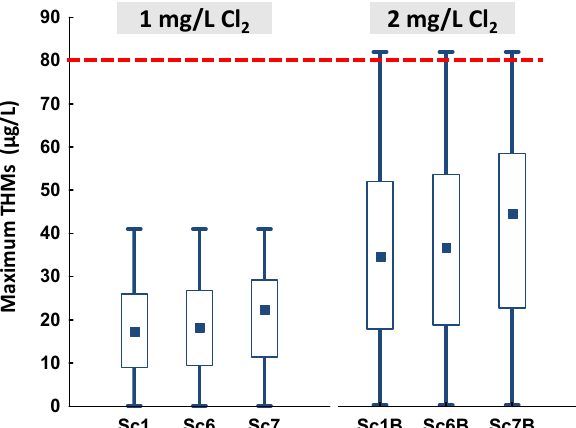
Figure 6. Distribution of maximum THM levels during a whole day period for all nodes in Sc1, Sc6, and Sc7 at 1 and 2 mg/L Cl 2 at the WTPs. Median; Box: 10–90%; Whisker: min-max. Red line: maximum acceptable level of THMs (80 μ g/L) (USEPA, 2012).